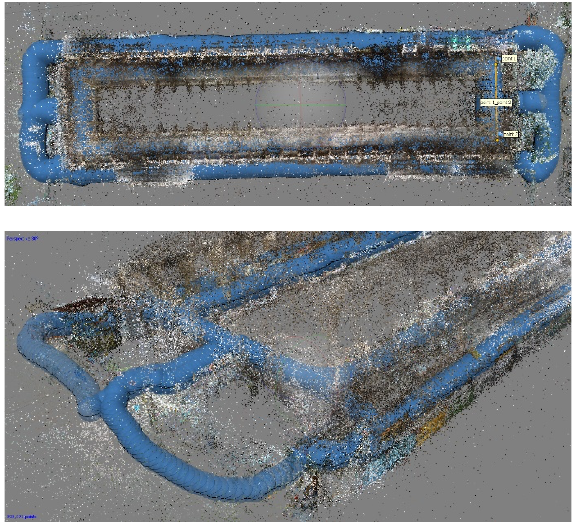
Figure 17 . Images showing the orientation results. 4.2.1